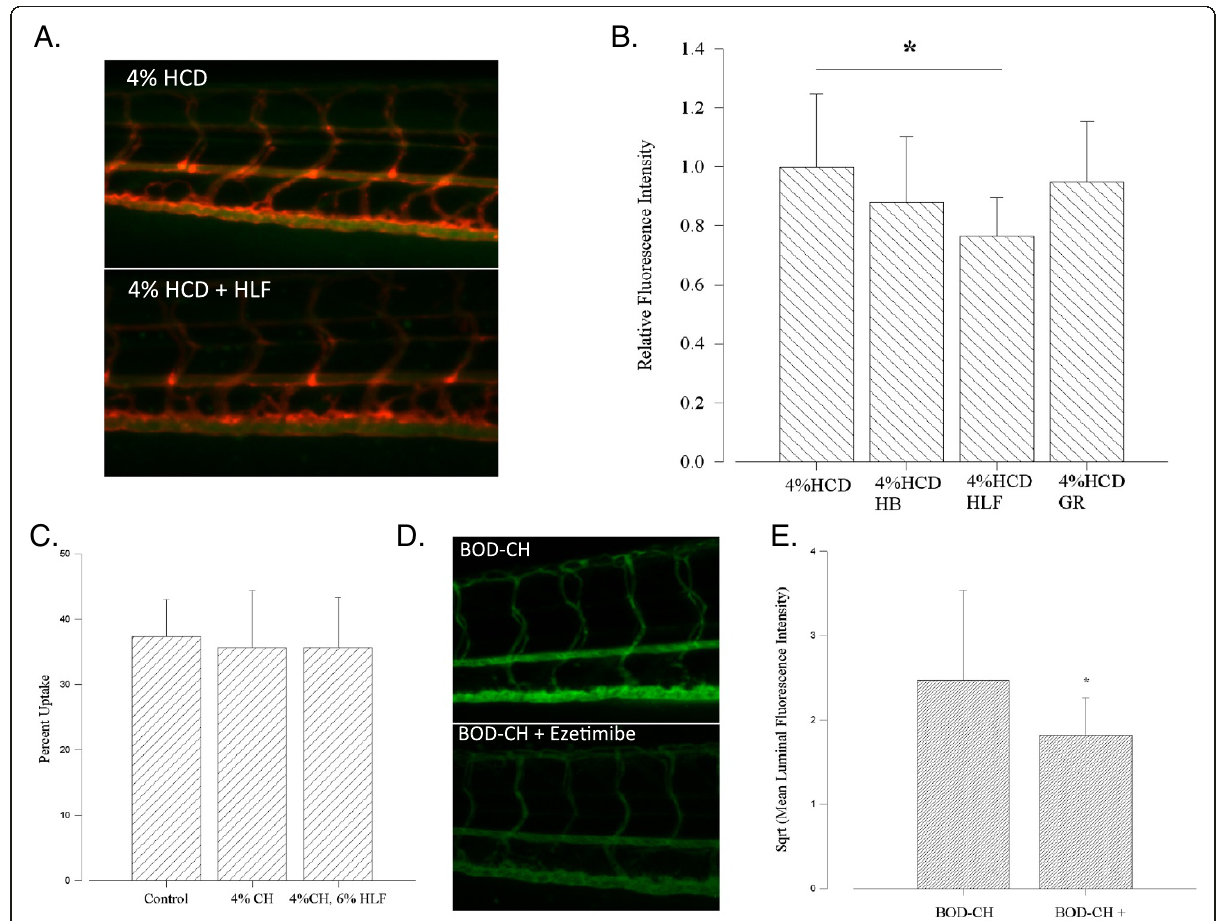
Figure 2 Hawthorn Leaves and Flowers (HLF) Decrease BODIPY-cholesterol fluorescence in 4%HCD-fed fish. A . Representative images of the vasculature of fish in 4%HCD and 4%HCD+HLF treated fish. Orange vasculature from TG(Kdrl:mCherry)/Casper line. Green is intravascular BOD- CH fluorescence B . Fluorescence output comparison between groups. Analyzed relative to mean of 4% HCD group having a value of 1. Significant difference between HLF and 4%HCD treated fish. * P<0.05, bars are mean±S.D. 1-way ANOVA, Holm-Sidak post-hoc multiple comparison. n=15- 17 per group. C . Comparison of percent uptake between untreated (control), CH-treated, and CH+HLF-treated diets. Five in each experimental group, with the experiment repeated 3x, showed similar uptake (P=0.925, bars are mean±S.D. of repeated experiments. 1-way ANOVA). D . Representative Images of BOD-CH treated and BOD-CH+Ezetimibe treated fish (4 dpf). E . Ezetimibe treatment decreases intravascular BOD-CH fluorescence (* P<0.05, bars are mean±S.D. 1-way ANOVA, Holm-Sidak post-hoc multiple comparison. n=13-14 per